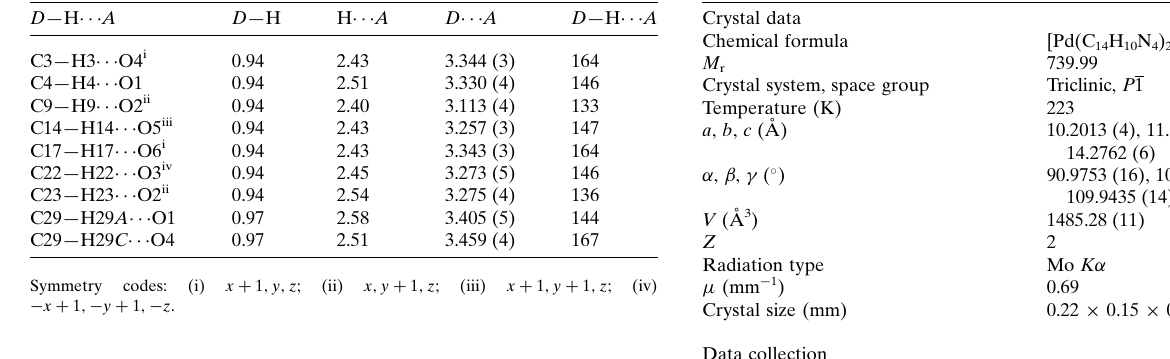
Table 1 Hydrogen-bond geometry (A˚ , (cid:4) ).